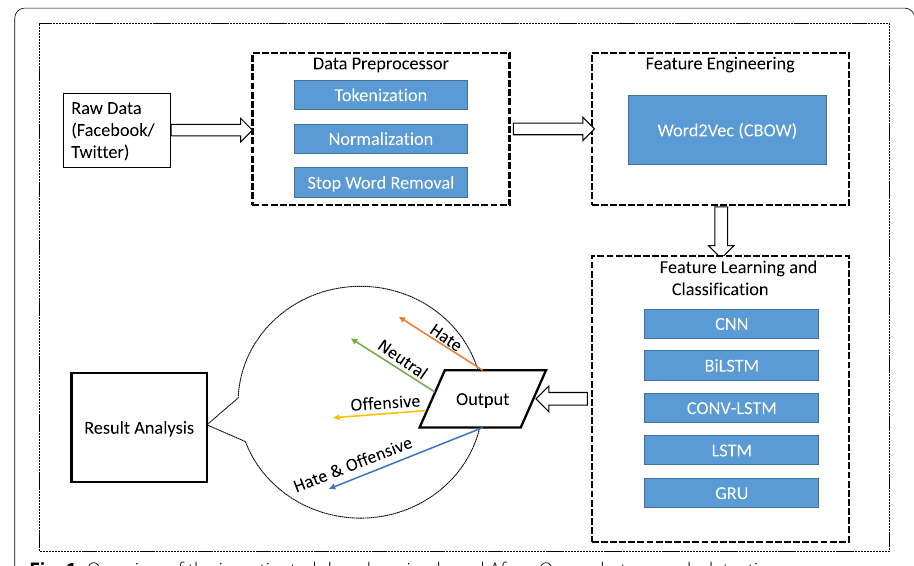
Fig. 1 Overview of the investigated deep learning based Afaan Oromo hate speech